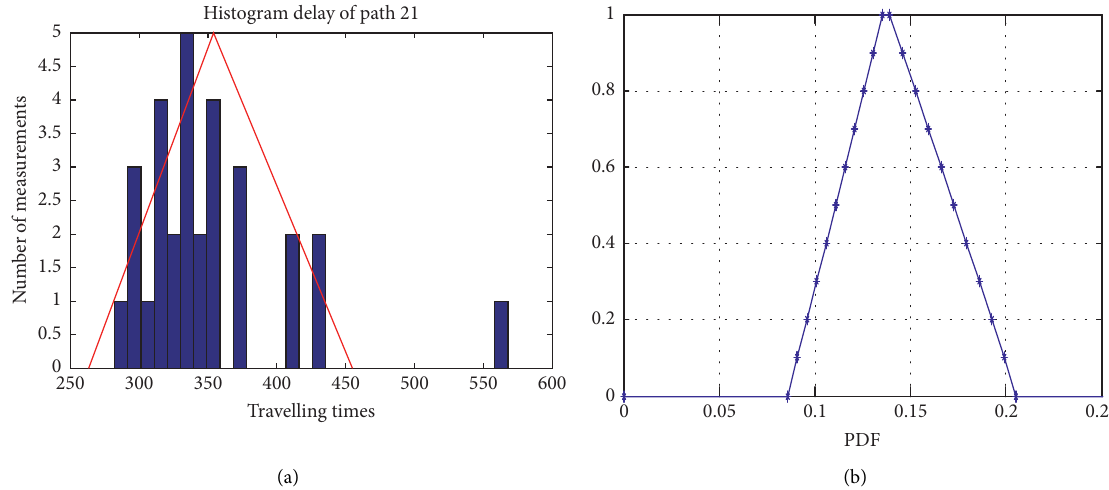
Figure 15: (a) Triangular PDF of the travelling time between Mahdia and Faculty stations (Mahdia to Sousse direction). (b) Membership function for the PDF of travelling time.